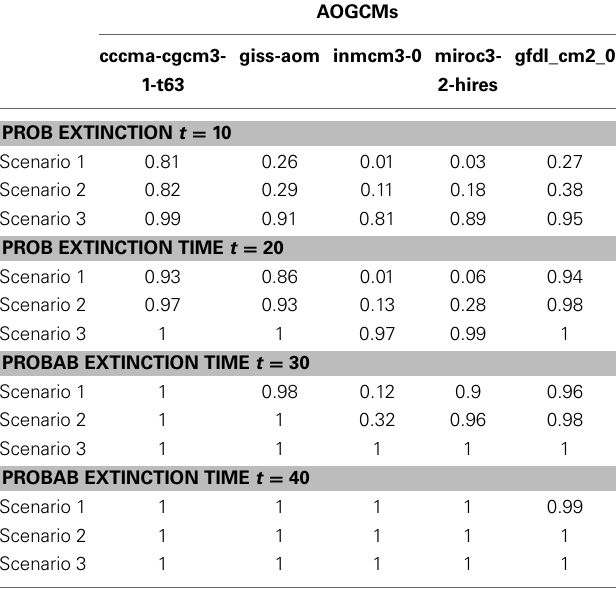
Table 1 | Probability of extinction of the Adélie penguin population of Edmonson Point at time t = 10, 20, 30, and 40 years after 2010, for five AOGCMs and three environmental